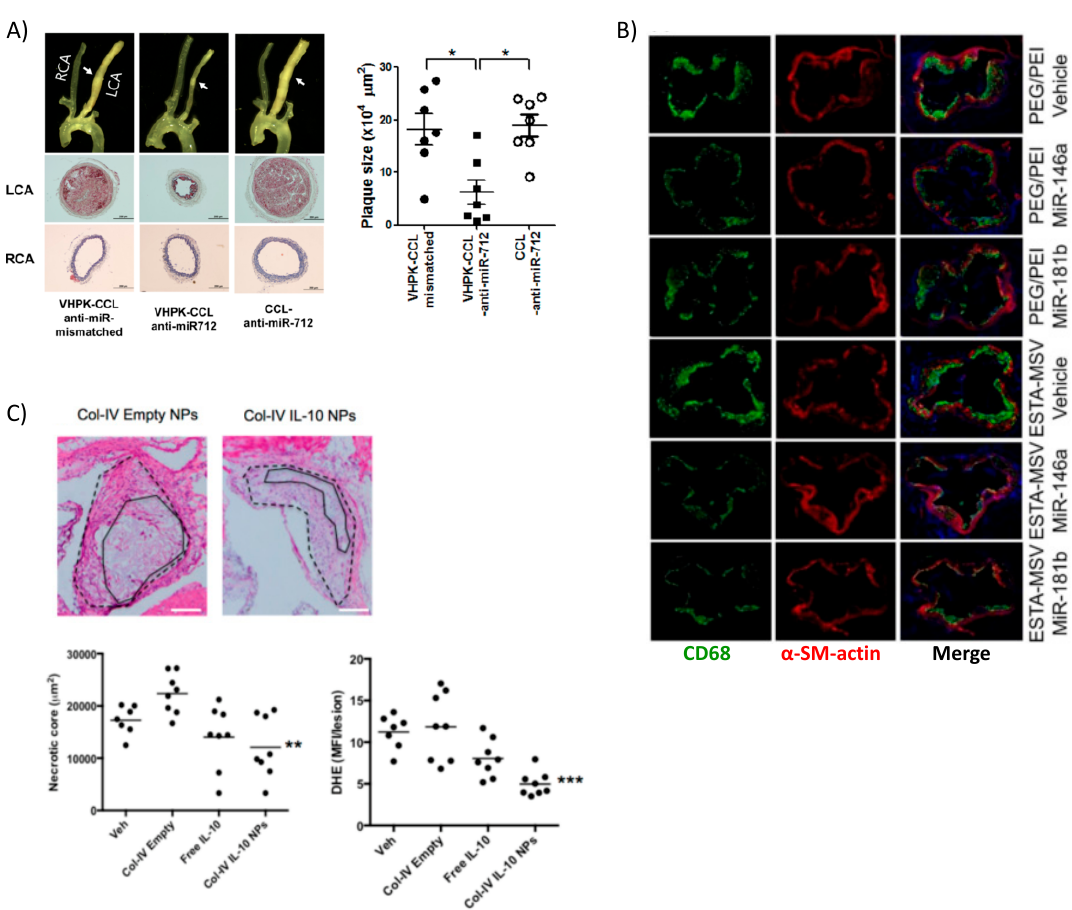
Figure 5. Targeted delivery of biotherapeutics from various nanoparticle formulations. ( A ) Surgical models of atherosclerosis lead to disturbed blood flow in ligated artery (LCA) vs. non-surgery control normal flow (RCA) resulting in overexpression of VCAM-1 used by targeted lipoparticles delivering miRNA. Targeted liposomes (VHPK-CCL anti-miR-712) resulted in decreased plaque size, collagen content, and other markers of inflammation (* p < 0.05). Reprinted (adapted) with permission from [51]; ( B ) PEI-mediated delivery of athero-protective miRNA encapsulated in silica microparticles targeting E-selectin reduced overall macrophage content within plaques, marking a reduced inflammatory response. Reprinted (adapted) from [60]; ( C ) Collagen-IV targeted PLGA NPs encapsulating anti-inflammatory cytokine IL-10 also localized to the plaque and reduced necrotic core size and generation of ROS. Reprinted (adapted) with permission from Kamaly, N. et